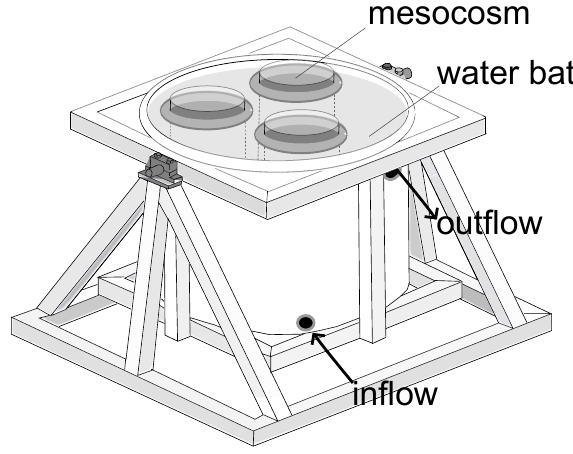
Fig. 2. Schematic draft of three shipboard mesocosms floating in a gimbal-mounted water